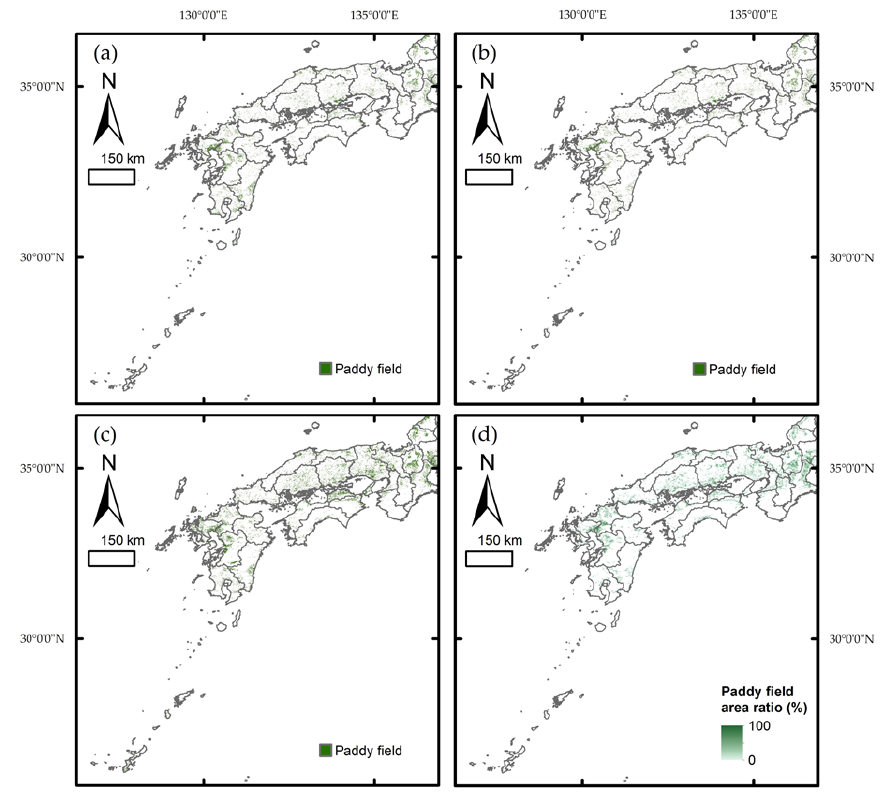
Figure 8. Comparison of paddy field maps of western Japan developed in this study with the existing maps. Paddy fields in 2018 on the maps developed by the ( a ) S-1 and ( b ) S-1 & S-2 methods (30 m spatial resolution). ( c ) Paddy fields in 2014–2016 on the JAXA map (30 m spatial resolution). ( d ) Paddy fields in the early 2000s on the TY map (1 km spatial resolution).